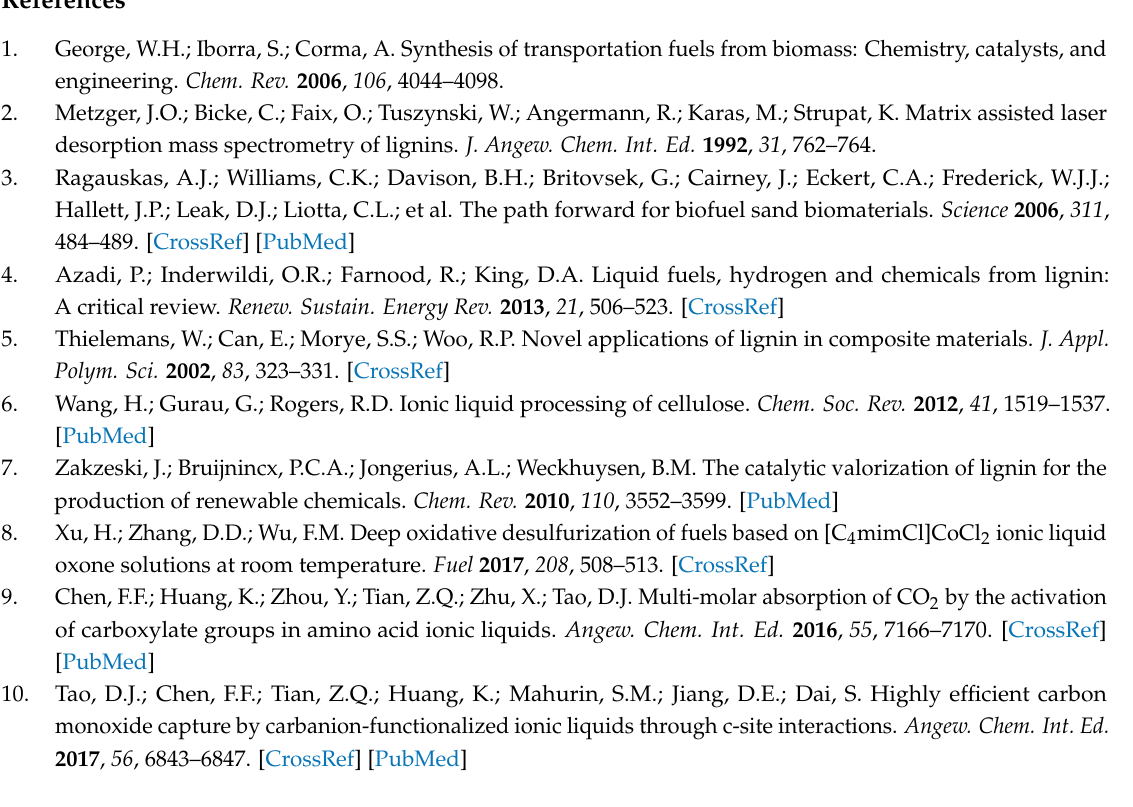
Figure S1: The 13 C NMR spectra of [Ch][Na] in H2O/[Ch][Na] ( R = 10) solvent at room temperature; Figure S2: The 13 C NMR spectra of [Ch][CH3CH2COO] in [Ch][Na] in H2O/[Ch][Na] ( R = 10)/lignin (8 wt %) solution at room temperature; FT-IR spectra analysis of the original lignin and the regenerated lignin; Measurements of the thermal properties of [Ch][Na], [Ch][Fa], [Ch][Va] and